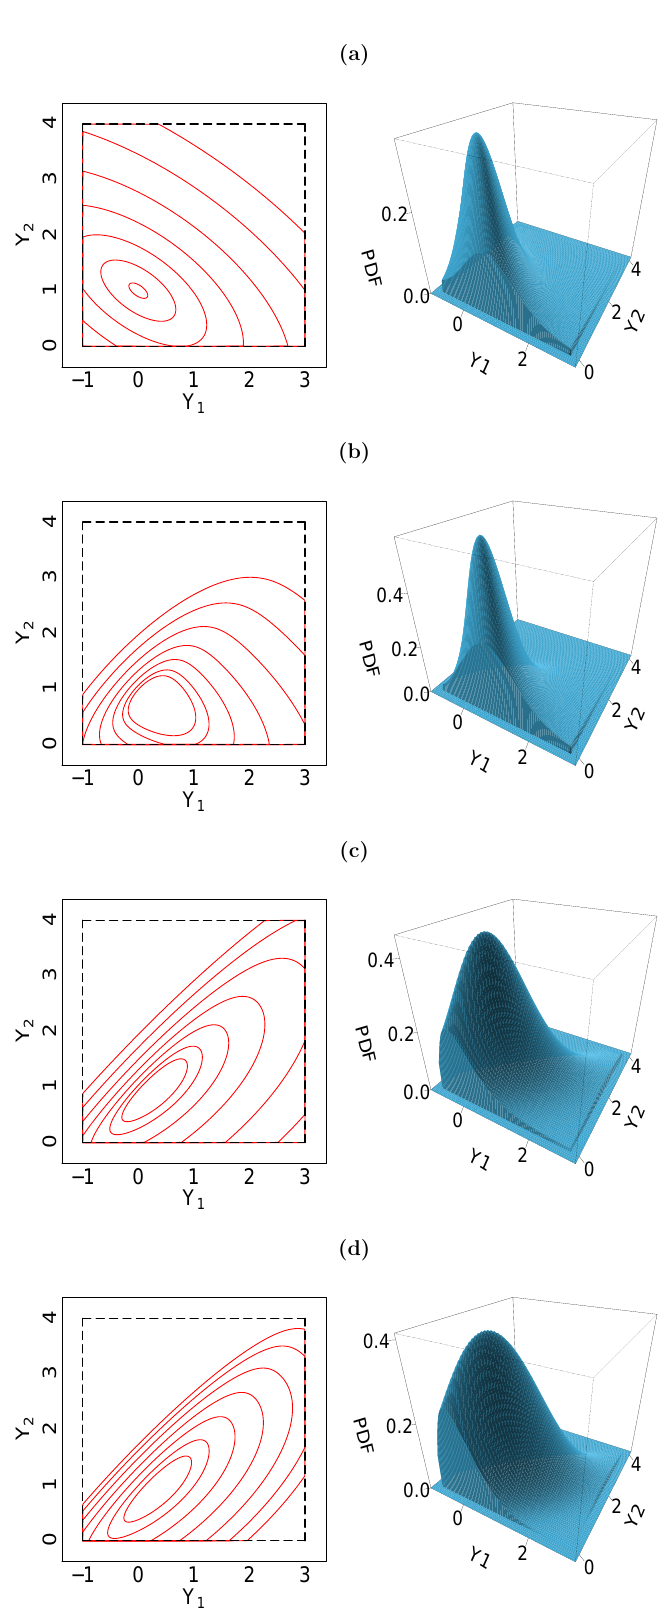
Figure 1. Contour plots (at levels 0.33, 0.25, 0.14, 0.06, 0.02, 0.006, 0.002) and PDF of Y ∼ TST 2 ( ξ , Ω , α , ν ; R ) , where: ( a ) ξ 1 = 0, ξ 2 = 1, ω 11 = 1.2, ω 22 = 0.8, ω 12 = − 0.6, α 1 = α 2 = 0, ν = 3, R = ( − 1,3 ) × ( 0,4 ) ; ( b ) α 1 = 4, α 2 = − 3; ( c ) ω 12 = 0.6; ( d ) ν = ∞